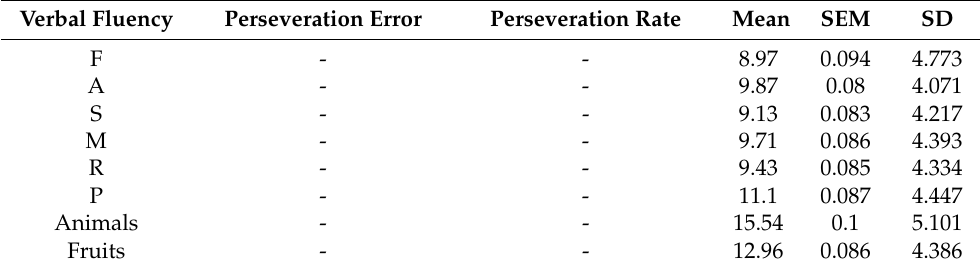
Table 1. Phonologic and semantic verbal fluency of all healthy participants ( n = 2602).